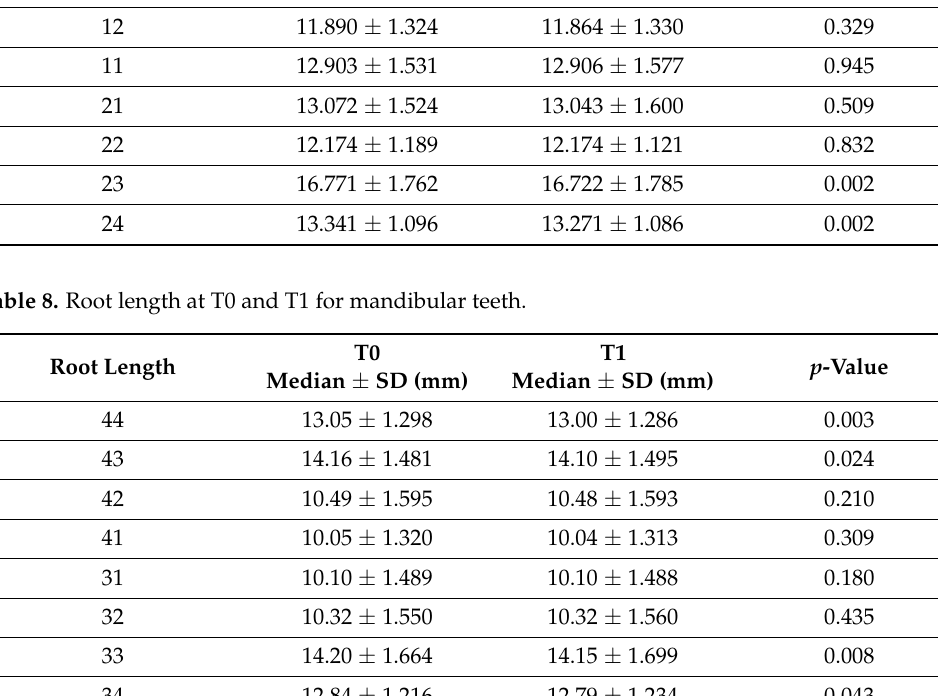
Table 8. Root length at T0 and T1 for mandibular teeth.